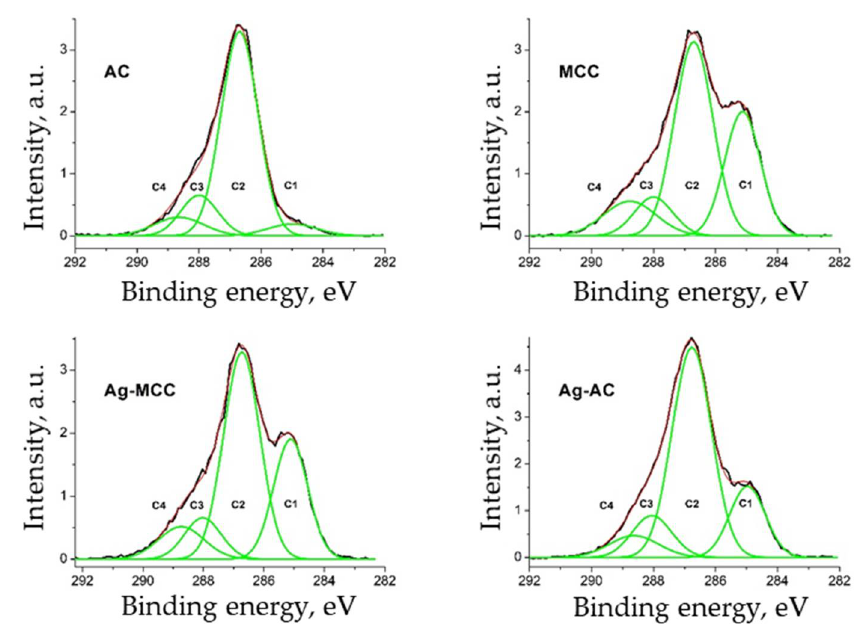
Figure 12. High resolution C 1s core-level spectra fitted with four components for the initial micro- crystalline cellulose powder (MCC), cellulose aerogel (AC) as well as corresponding composites with Ag NPs (Ag-MCC and Ag-AC).